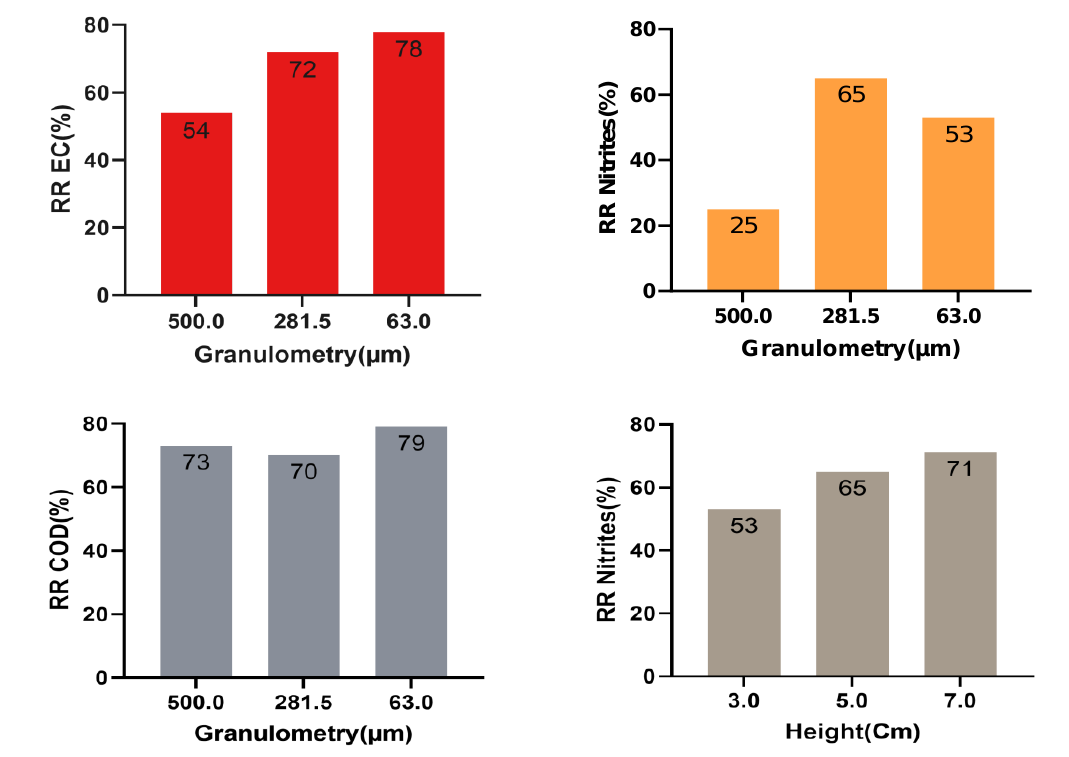
Figure 5. Parametric removal percent as a function of particle size (effluent pH = 6.5; tempera- Figure 9. Parametric removal percent as a function of particle size (effluent pH=6.5; temperature =30 ture = 30 ◦ C, particle size range between 63–500 µ m; bed height = 7 cm; flow rate 20 mL.min − 1 ). °C, particle size range between 63 – 500 µm; bed height= 7 cm; flow rate 20 mL.min − 1 ).